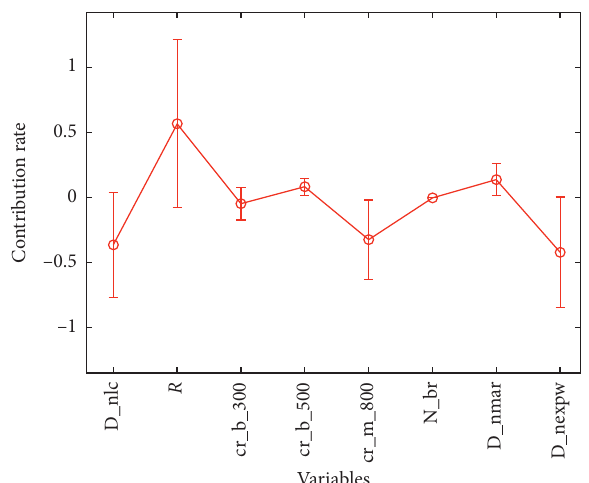
Figure 8: Contribution rate of different built environment variables.